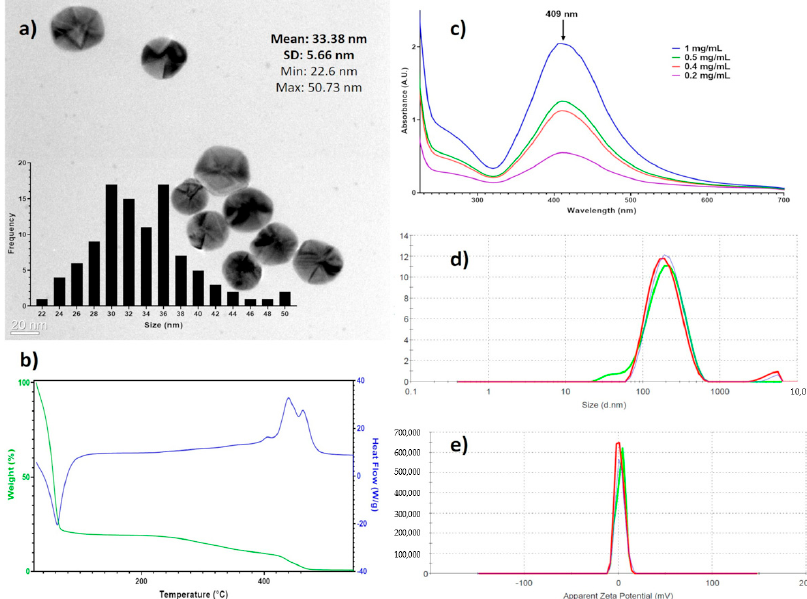
Figure 1. Physicochemical characterization of BioArgovit silver nanoparticles. ( a ) HR-TEM images that show the morphology of silver nanoparticles (The insert corresponds to the size distribution histogram); ( b ) the thermogravimetric analysis of the formulation (TGA) / differential scanning calorimetry (DCS); ( c ) surface plasmon resonance by UV–Vis; ( d ) hydrodynamic diameter determined by dynamic light scattering (DLS), and ( e ) the zeta potential.